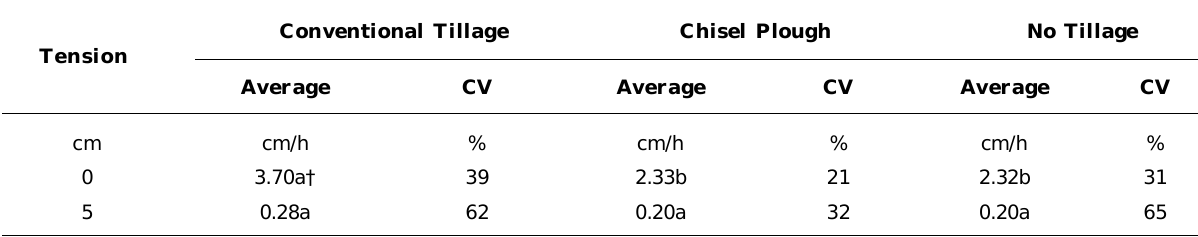
† The statistical analyses were performed with log-transformed values. Different letters of each water tension indicate statistically significant differences between treatments (LSD test; p=0.05).